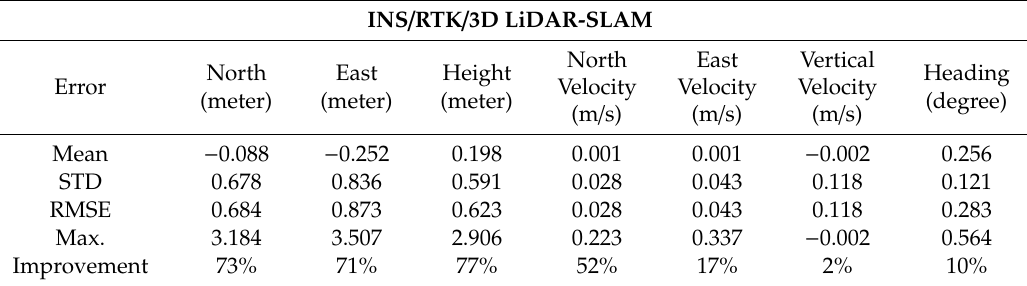
Table 3. Statistical analysis of INS / RTK / 3D